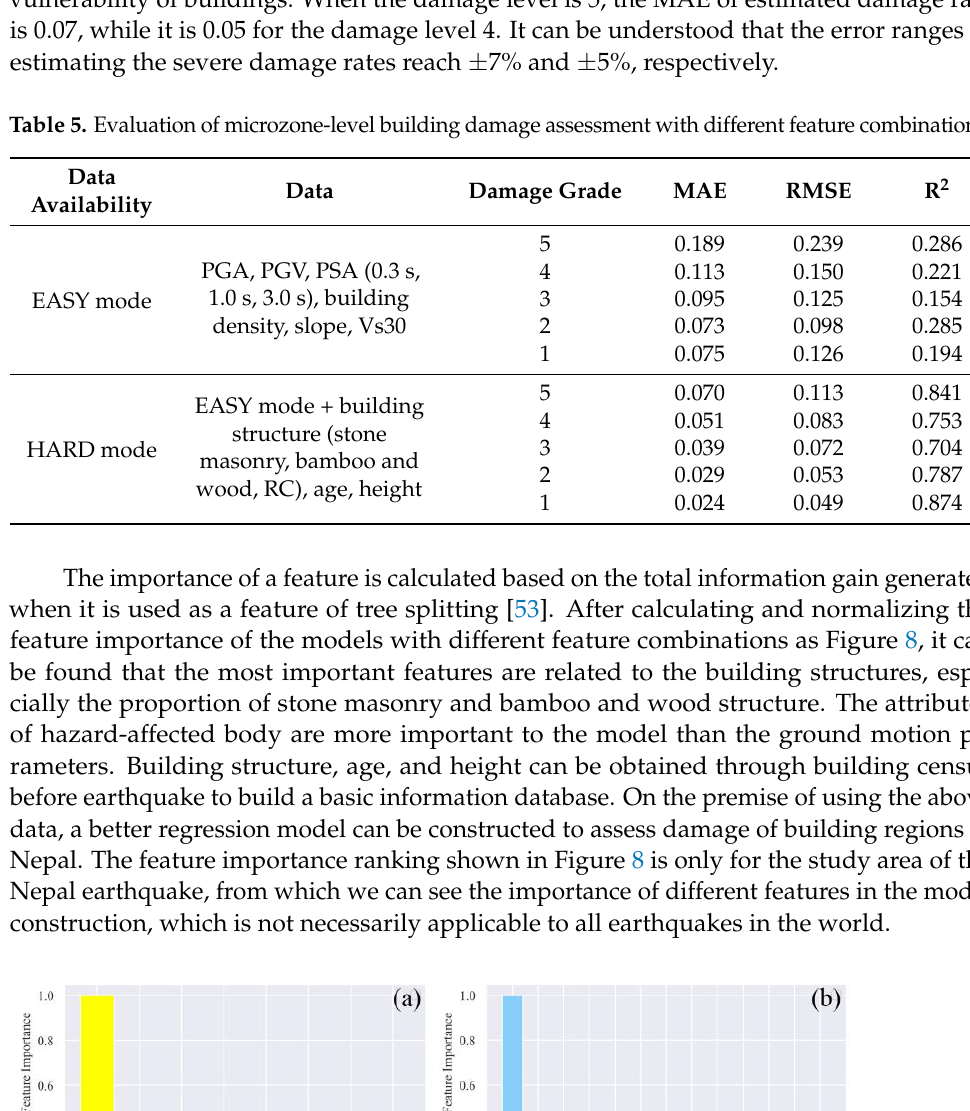
Figure 9. ( a , b ) Empirical fragility curves for stone masonry buildings in Nepal considering PGA and PSA0.3s as intensity measures. The building structures in the test area are mainly stone masonry, so that the fragility functions of stone masonry building can be used. We select the building regions where the stone masonry structure buildings account for more than 90% to compare the two methods. As shown in Table 6, it is obvious that the regression method using multiple data is better than the general fragility function, especially for the damage rate estimation of severe damage levels. When the damage level is 5, the estimation error of the fragility